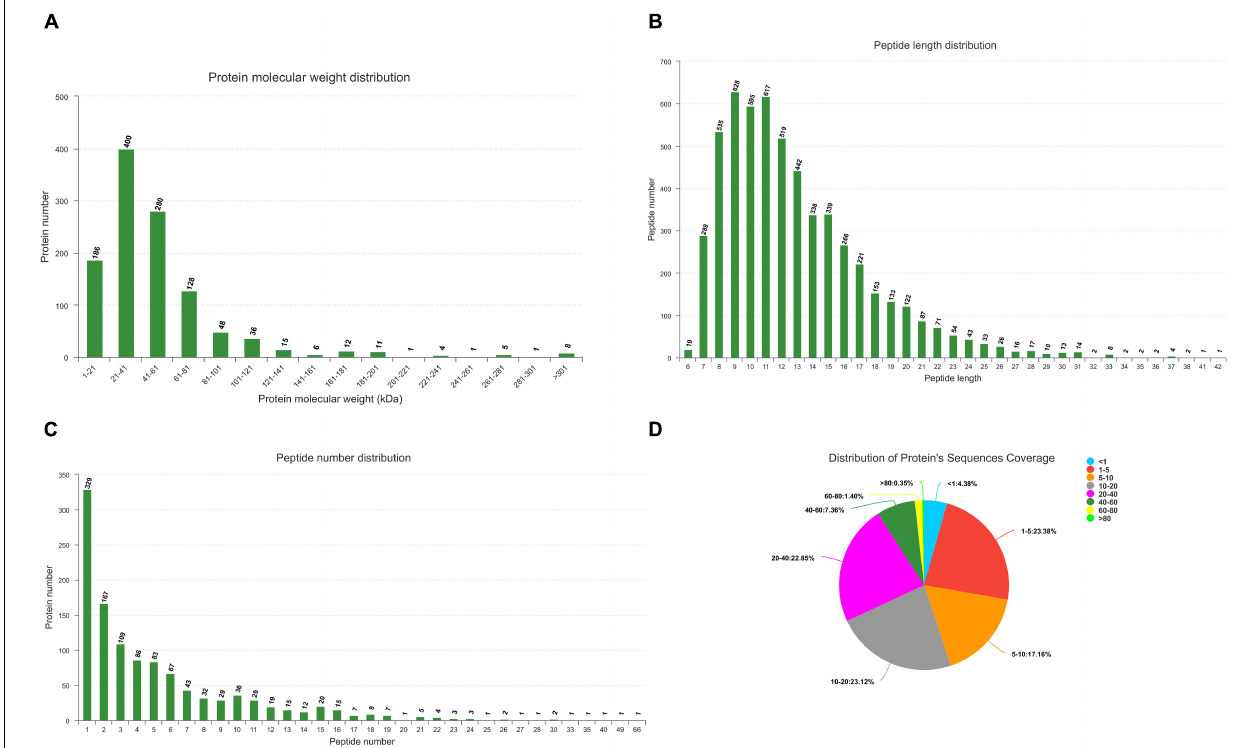
FIGURE 2 | Identification and feature of proteins in Ningxiang pigs. (A) Distribution of protein molecular weight. (B) Length distribution of peptide. (C) Number distribution of peptide. (D) Distribution of protein’s sequnences coverage. Each sector represents the proportion of a coverage range. The number outside the sector represents the coverage range and the proportion of proteins distributed in this